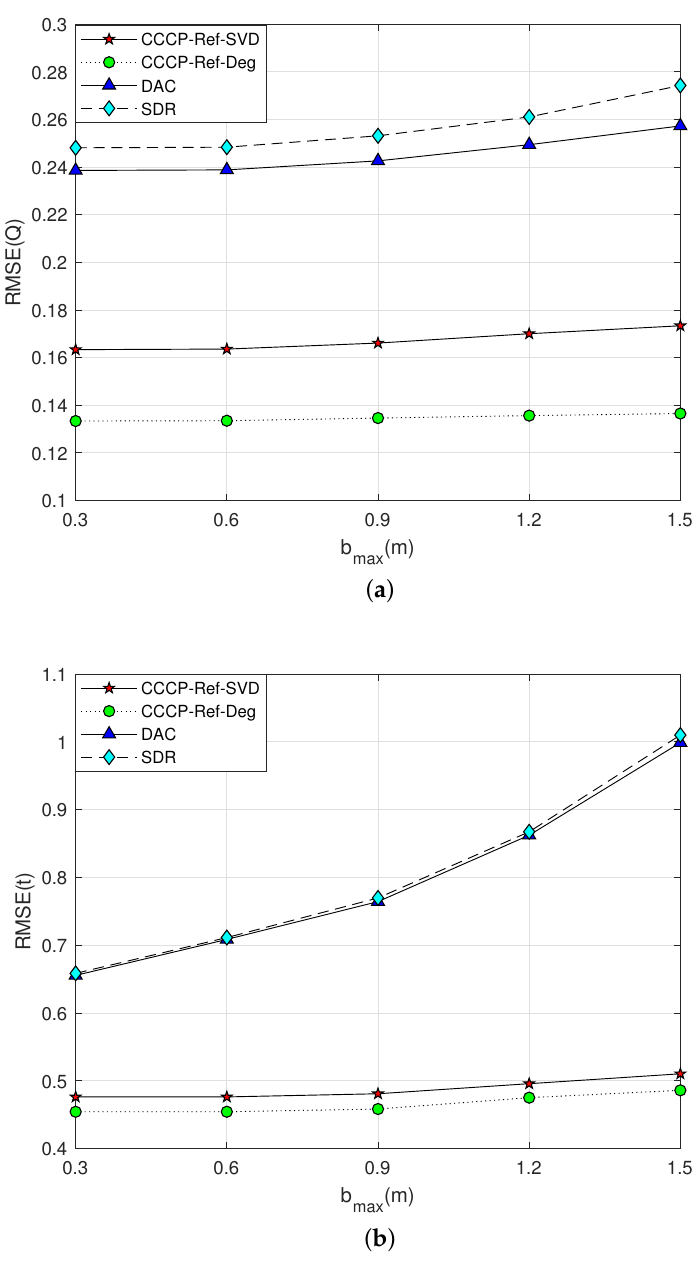
Figure 4. Performance curve of the rigid body’s posture parameter estimation with the maximum value of NLOS error b max increasing in 2–D case. ( a ) Q Estimation; ( b ) t